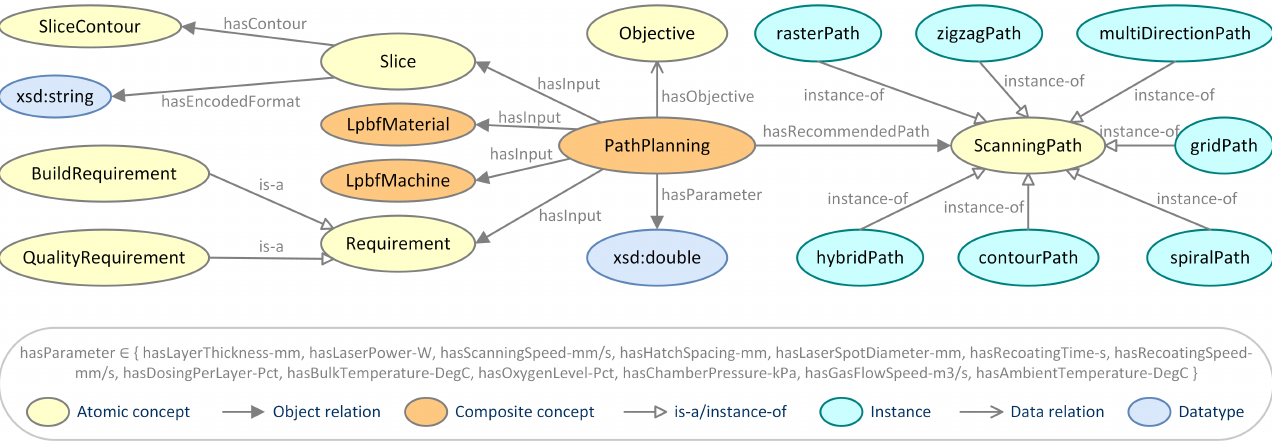
Figure 7. An ontological view of path planning for